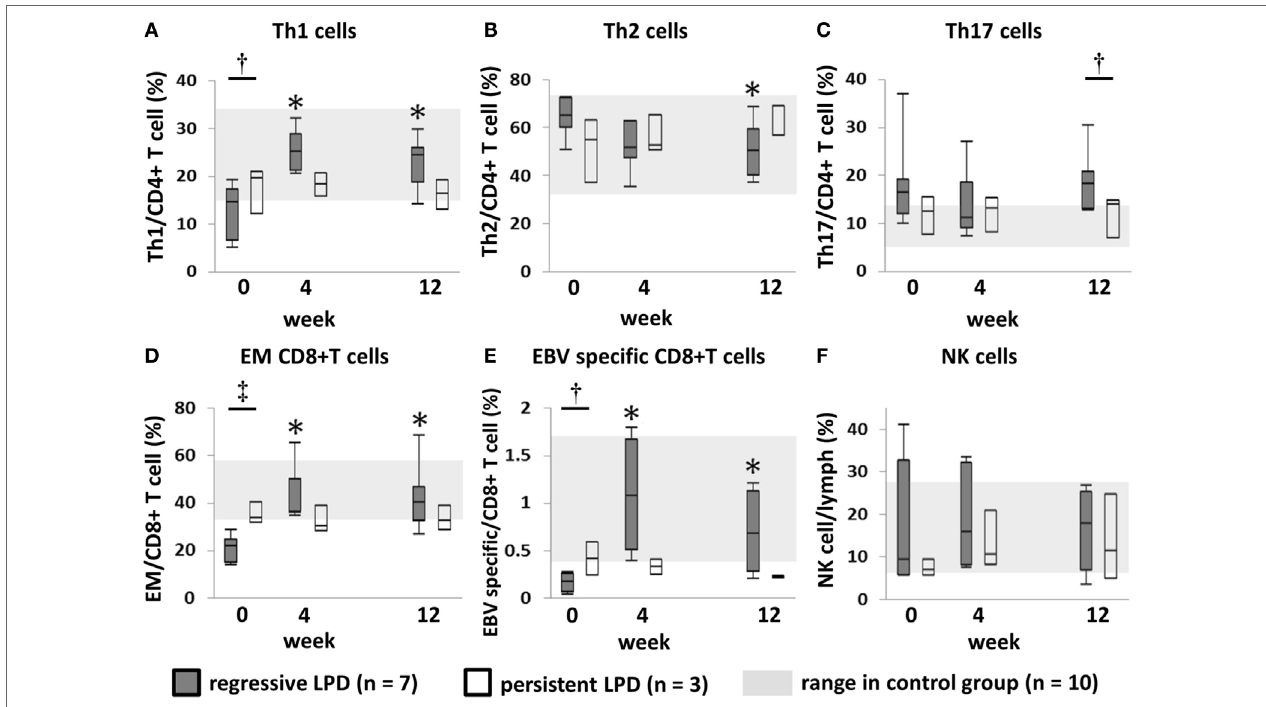
Figure 3 | Changes in the proportion of each lymphocyte subset after methotrexate (MTX) cessation. Transition of the proportion of (a) Th1, (B) Th2, and (c) Th17 cells among CD4 + T cells; (D) EMCD8 + T cells and (e) EBV-specific CD8 + T cells among CD8 + T cells; and (F) NK cells among lymphocytes, after MTX cessation. Comparison between the three groups was conducted using the Kruskal–Wallis test. † Regressive vs. control, P < 0.05. ‡ Regressive vs. control, P < 0.05; regressive vs. persistent, P < 0.05. * P < 0.05 for comparison with the value at week 0 in each group. Th1/2/17, T helper 1/2/17; EM, effector memory; EBV, Epstein–Barr virus; NK, natural